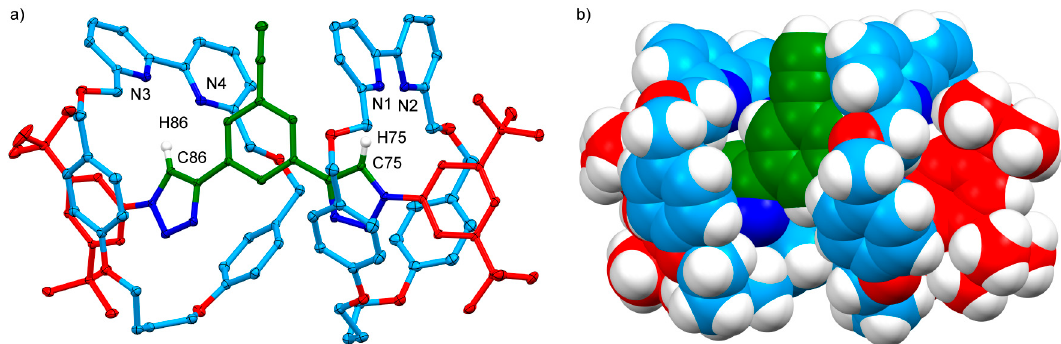
Figure 2. X-ray crystal structure of 8 shown as ( a ) ellipsoid; and ( b ) space-filling plots. Ellipsoids are shown at 50% probability. Some hydrogen atoms have been omitted for clarity. Interactions lengths (Å) and distances (°): H75···N1 2.392, H75···N2 2.688, C75-H75···N1 167.3, C75-H75···N2 126.0,